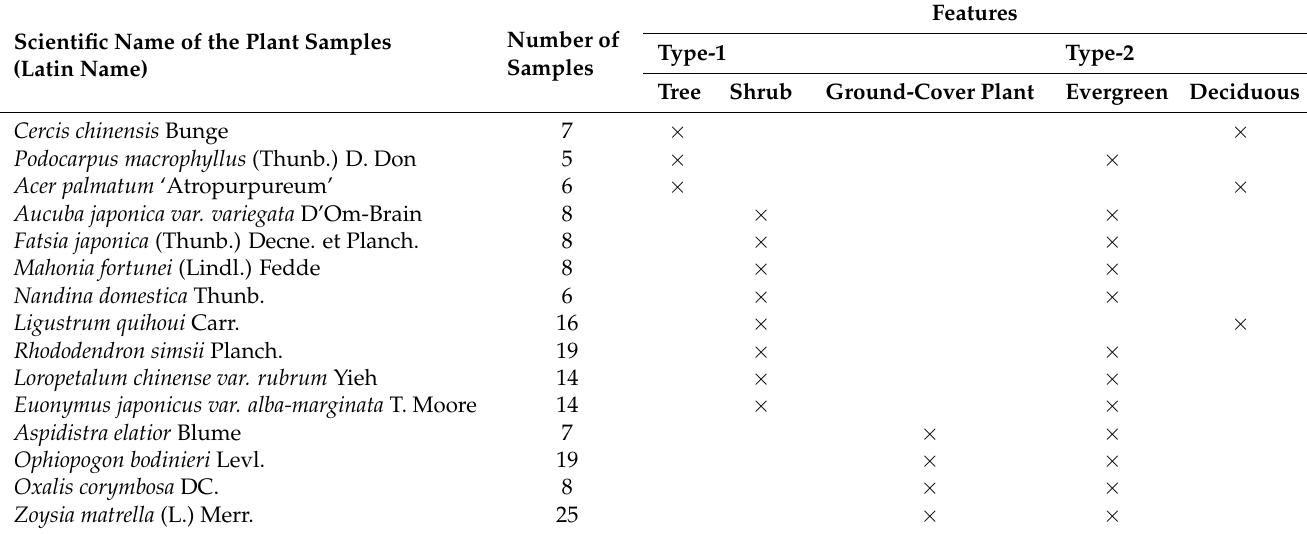
Table 3. Description of the landscape plant